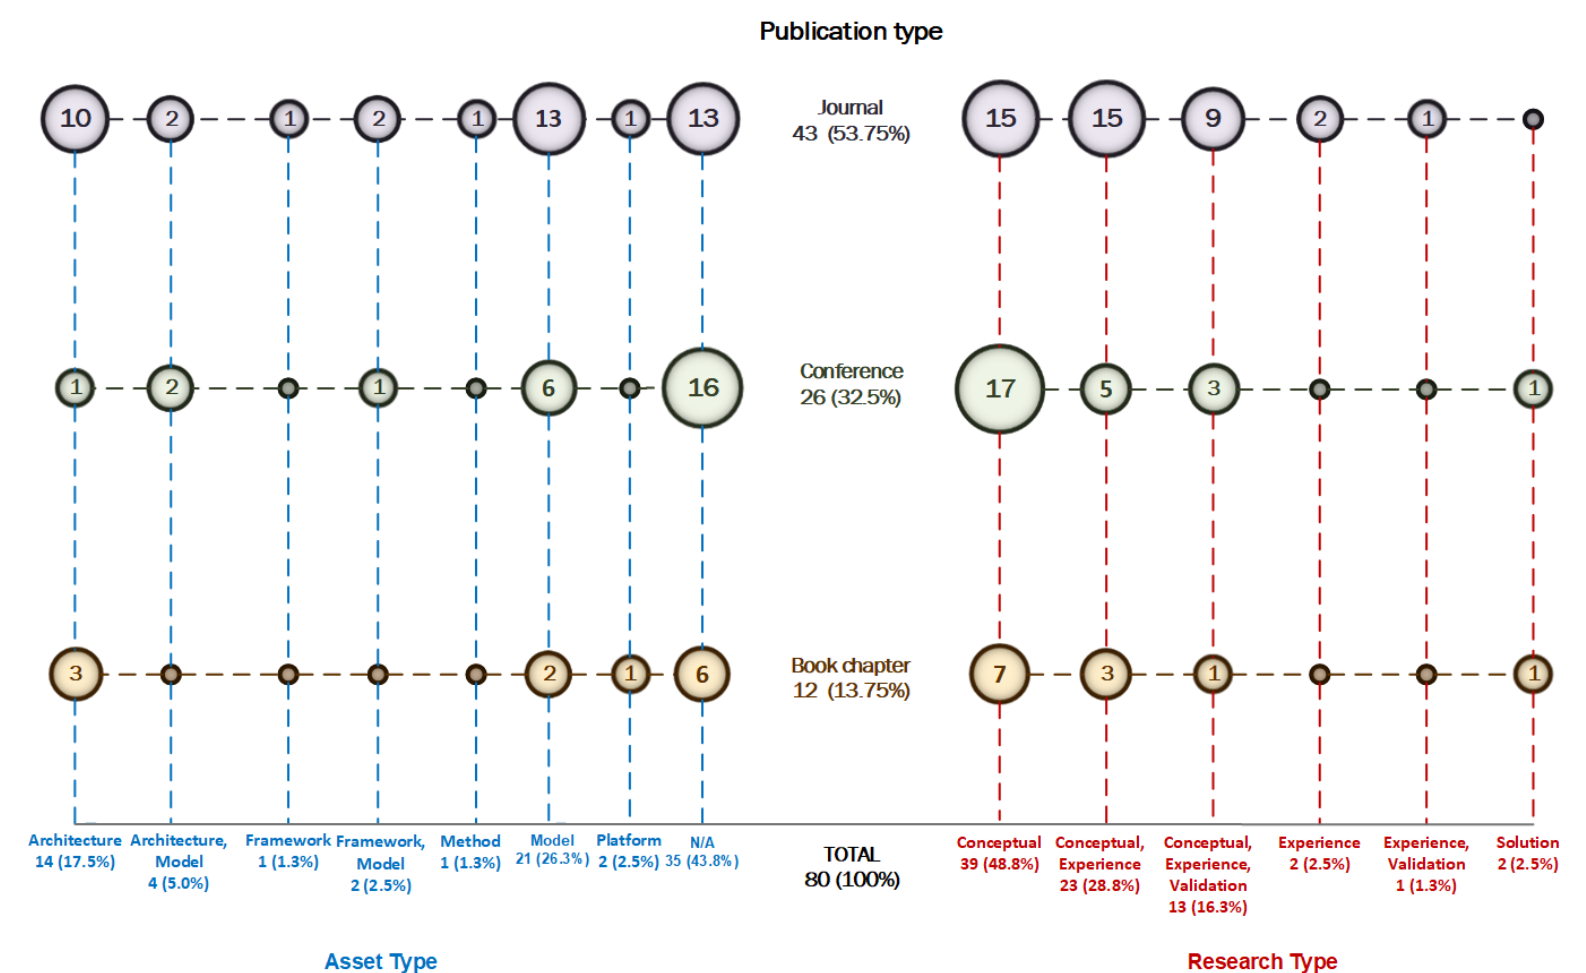
Figure 4. Mapping “Publication type” according to two dimensions: “Asset type” and “Research